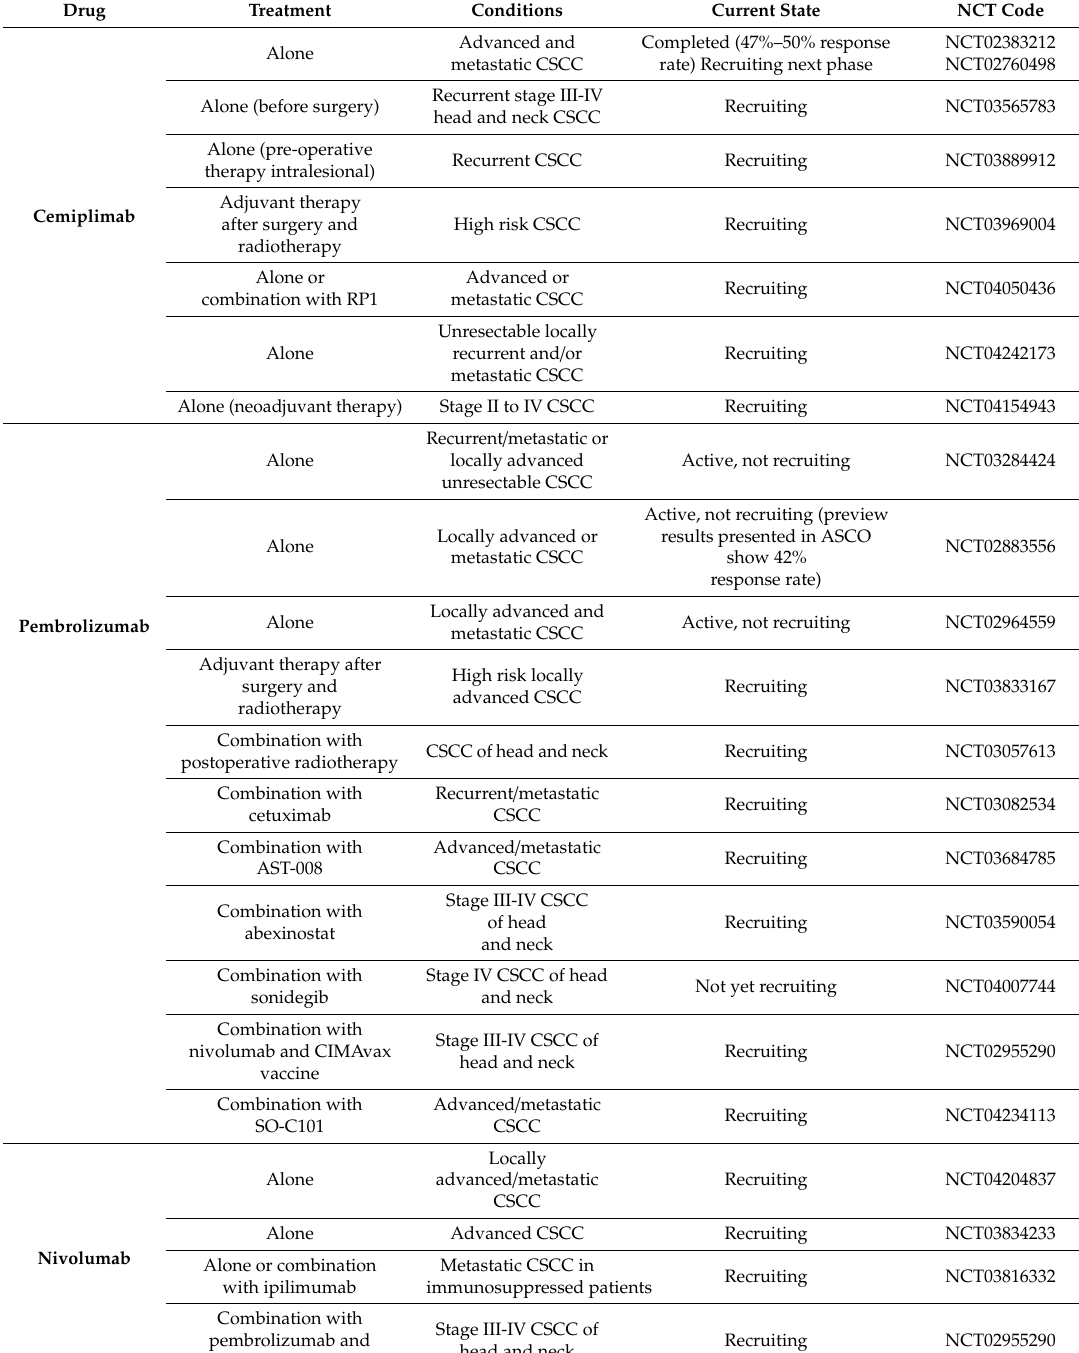
Table 2. Clinical trials of immunotherapy in cutaneous squamous cell carcinoma (revised until